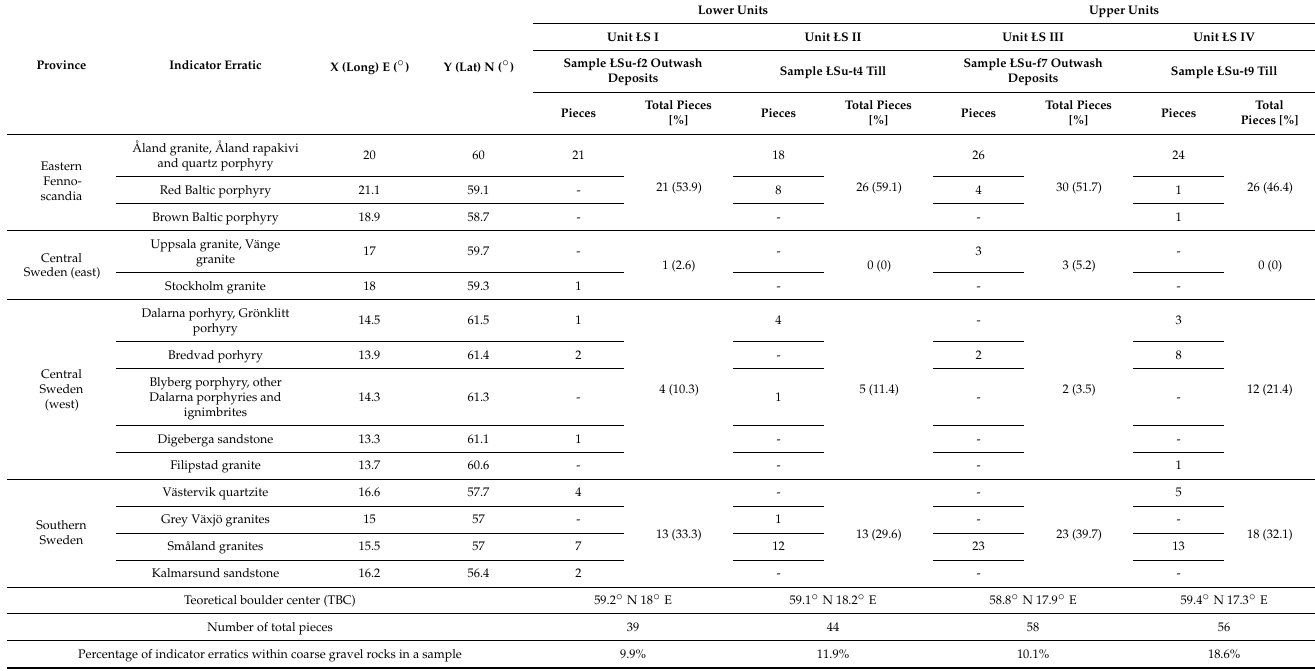
Table 2. Scandinavian indicator erratics, assigned to the province, of the coarse gravel fraction (20–60 mm) from the Łubienica-Superunki